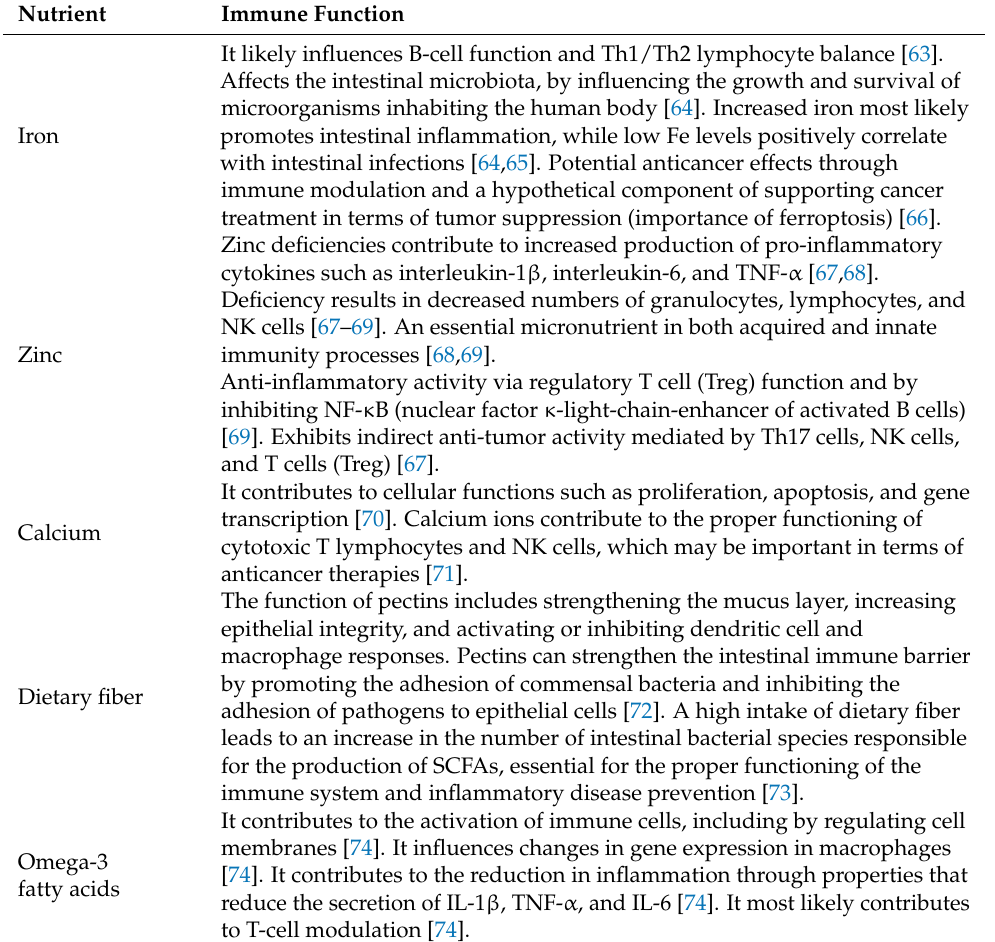
Table 2. Immunomodulatory effect of selected